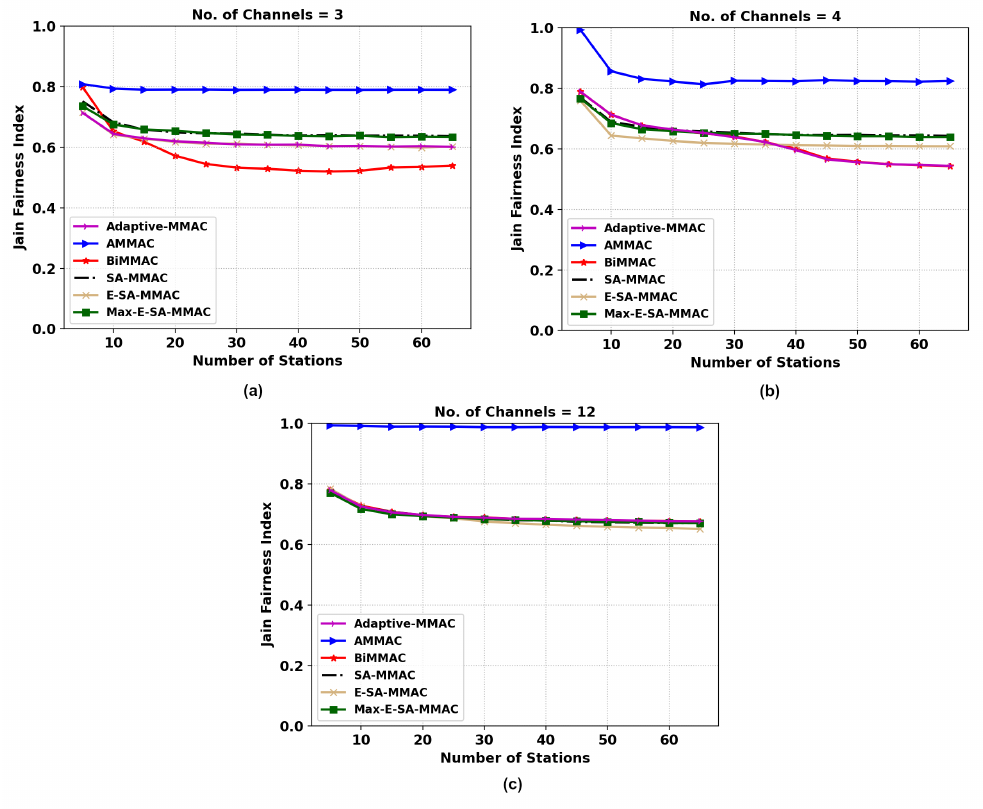
Figure 10. JFI comparison of adaptive MMAC versus others. ( a ) Three, ( b ) four, and ( c ) twelve channels.